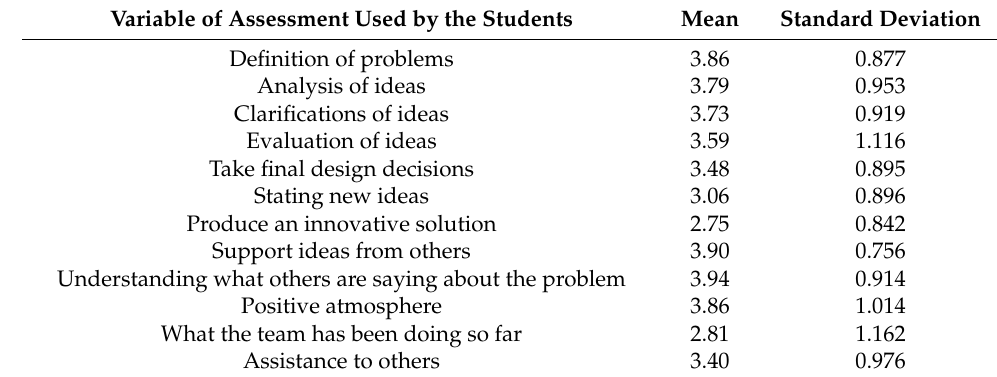
Table 1. The means and standard deviations of the aid provided by the design patterns, assessed by the students a